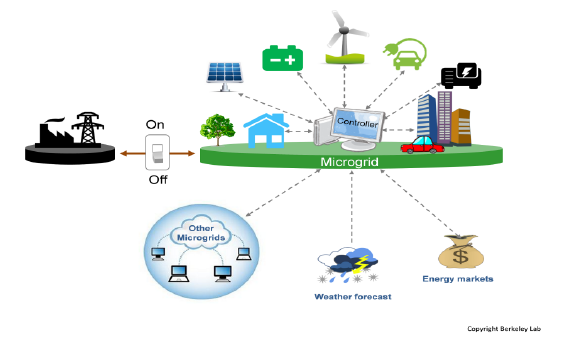
Figure 1. Microgrid architecture